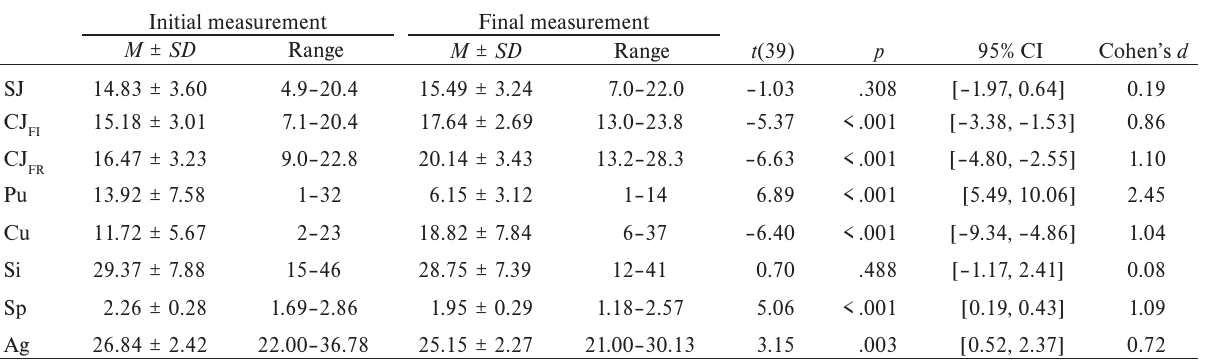
Table 1 The main descriptive indicators, differences, and effect size Initial